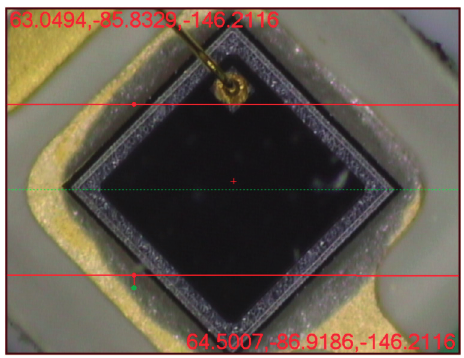
Figure 5. Photodiode assembly under image measurement tool. The green dotted line is the reference line for photodiode assembly. Numbers in the figure indicate the coordinate of the image corner point. (XYZ, Unit: